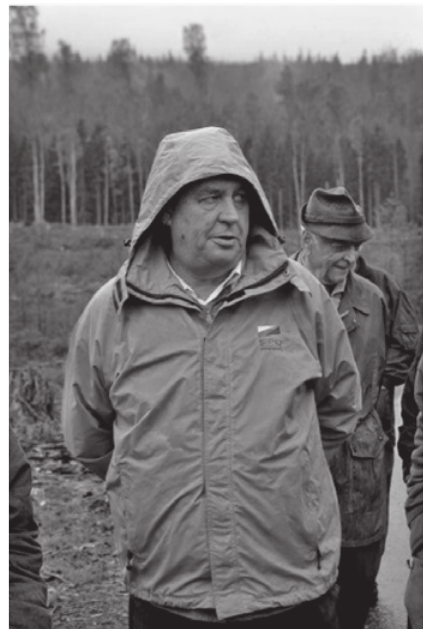
Fig. 5. Miloš Zeman, Lidovky.cz , 20. 1. 2013